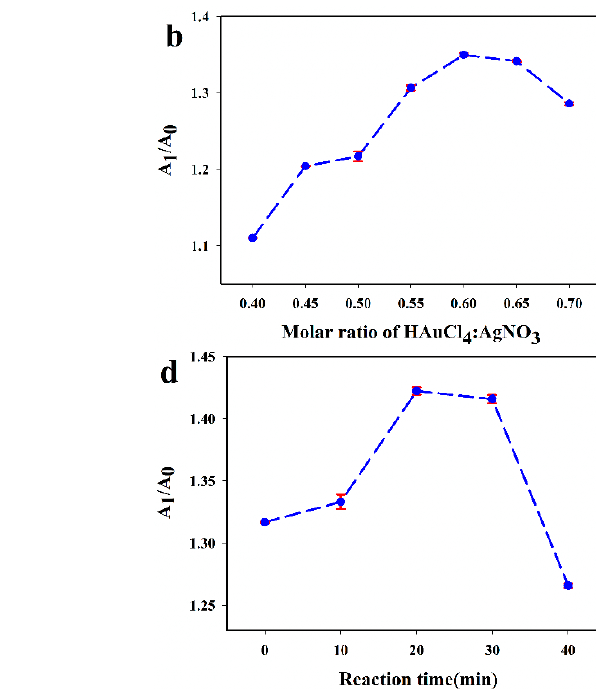
Figure 2. Effect of ( a ) HMT, ( b ) AgNO 3 , ( c ) reaction temperature and ( d ) reaction time on the synthesis of GNCs.